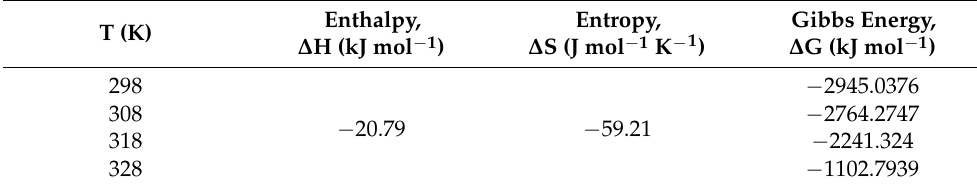
Figure 11. Mechanism for CIP adsorption onto the GA-MNPs.